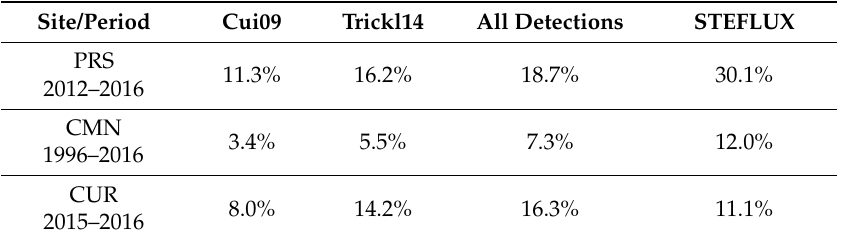
Table 2. Average frequency of in situ (“Cui09”, “Trickl14”, and “All detections”) and STEFLUX SI identification. In the first column, the comparison periods between in situ identification and STEFLUX are reported for each measurement